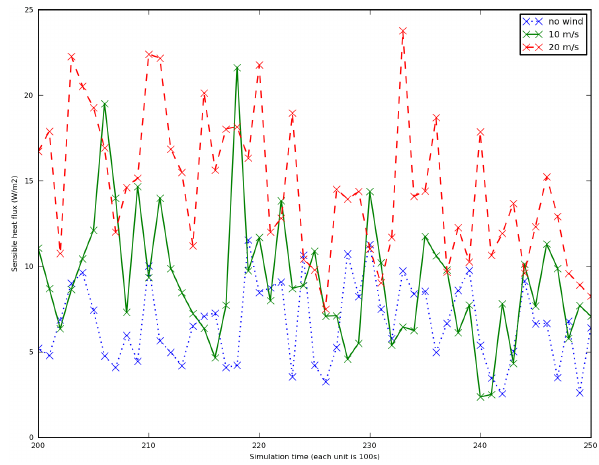
Fig. 3. Fluctuations of sensible heat flux with time. Cases with a 0ms − 1 (blue), 10ms − 1 (green) and 20ms − 1 (red) background wind are